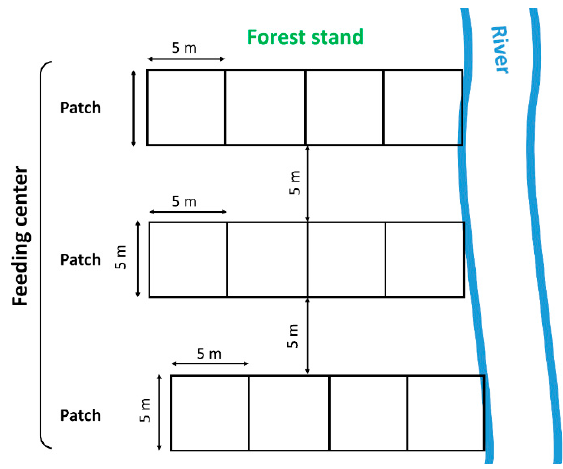
Figure 1. A schematic illustration of the method for staking out study patches in forest stands and their orientation to the